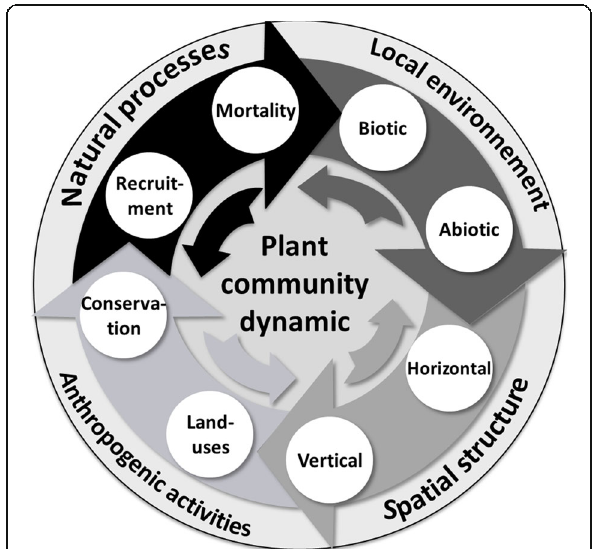
Fig. 5 The spatial structure of plant communities reflects its dynamic which is driven by the synergic effect of local environment, natural processes, and human operations. Spatial plant distribution reflects the community dynamic which is continuously modified by the interaction between natural processes and abiotic and biotic factors as well as anthropogenic land